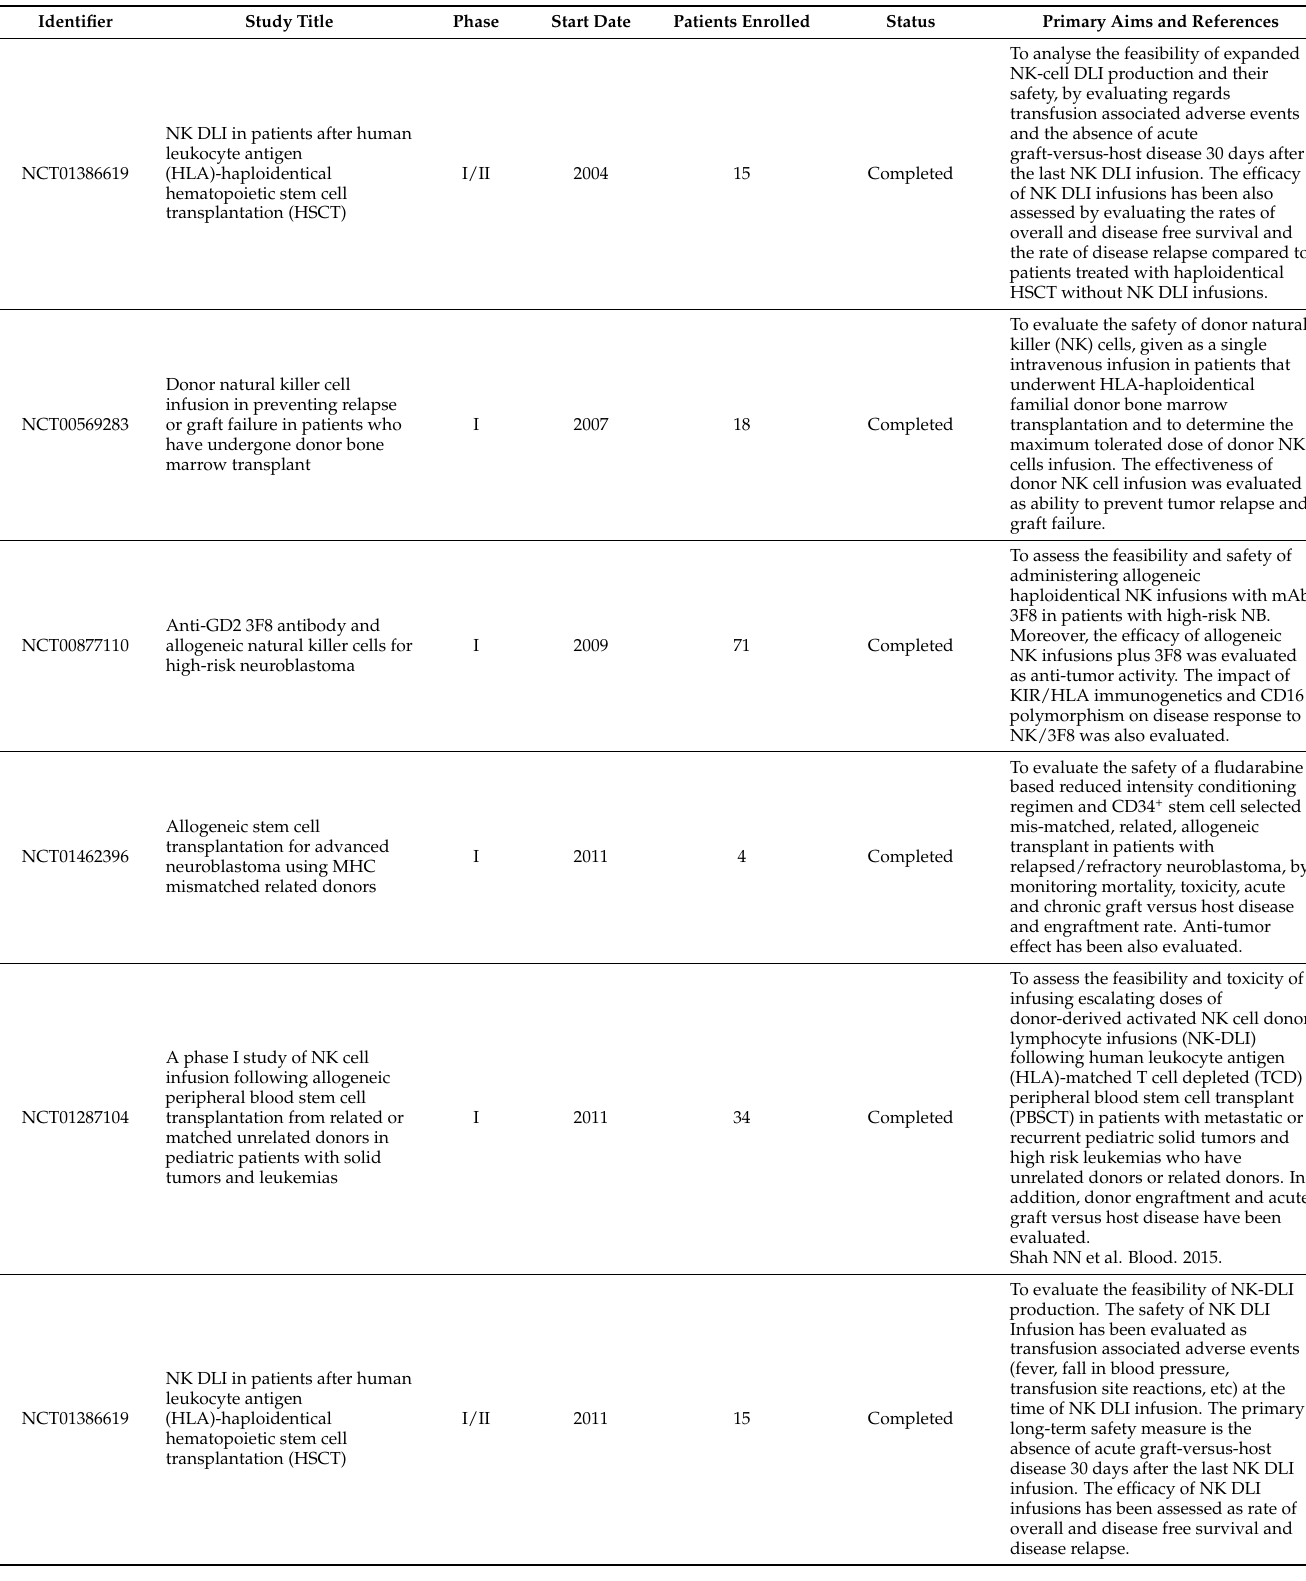
Table 3. Phase I/II Clinical trials of NK